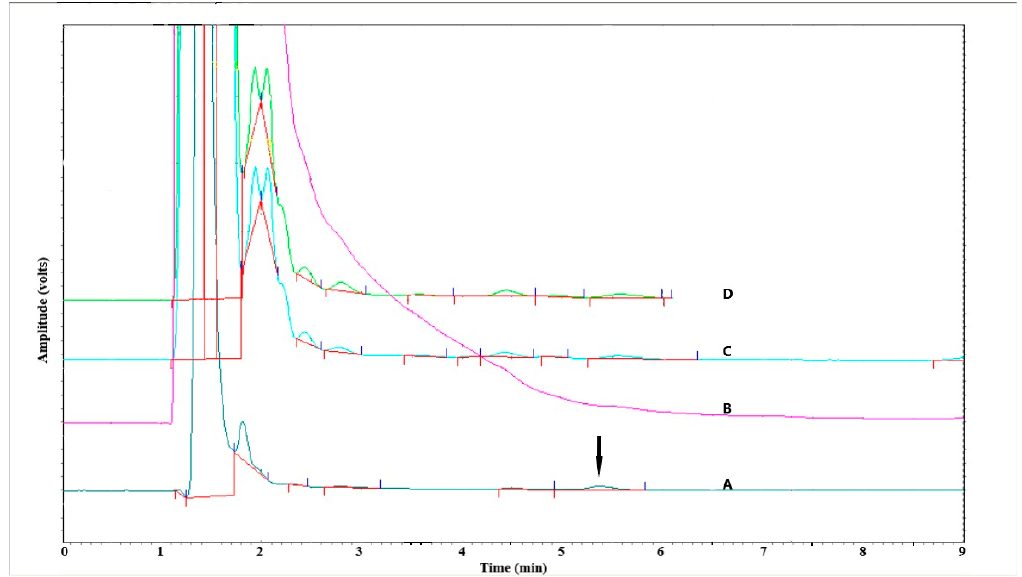
Figure 3. Chromatograms of ( A ) asenapine maleate (1 µ g/mL) and the co-formers ( B ) nicotinamide, ( C ) urea, and ( D ) succinic acid used in the preparation of co-crystals, indicating the specificity of the method. The arrow indicates the peak of the drug.